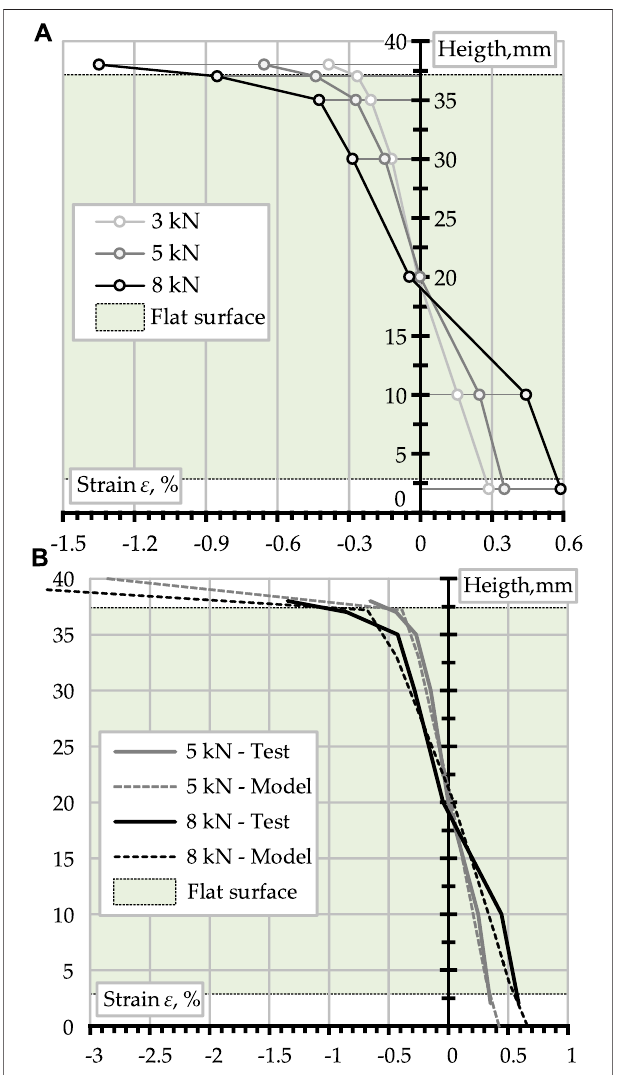
FIGURE 15 | Local strain distribution along U GIRA pro fi le height: (A) Digital image correlation (DIC) results; (B) Comparison of the DIC and FE modeling results (predictions by Model 3).